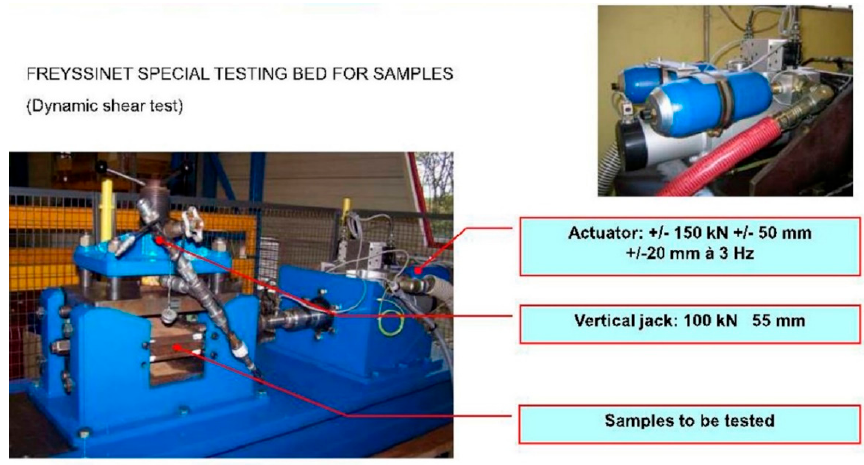
Figure 7. Dynamic shear test machine [13].